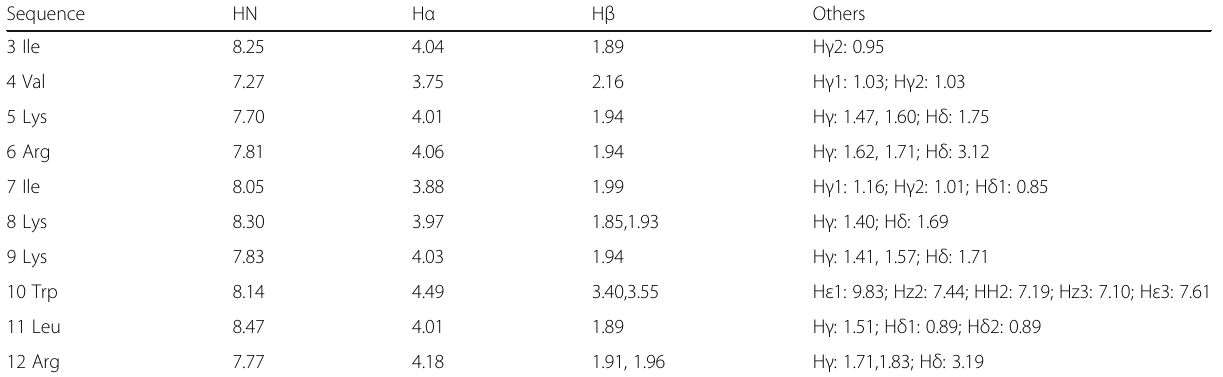
Table 1 Proton chemical shifts of KR-12-pa in 50% TFE at 298 K Sequence HN H α H β Others